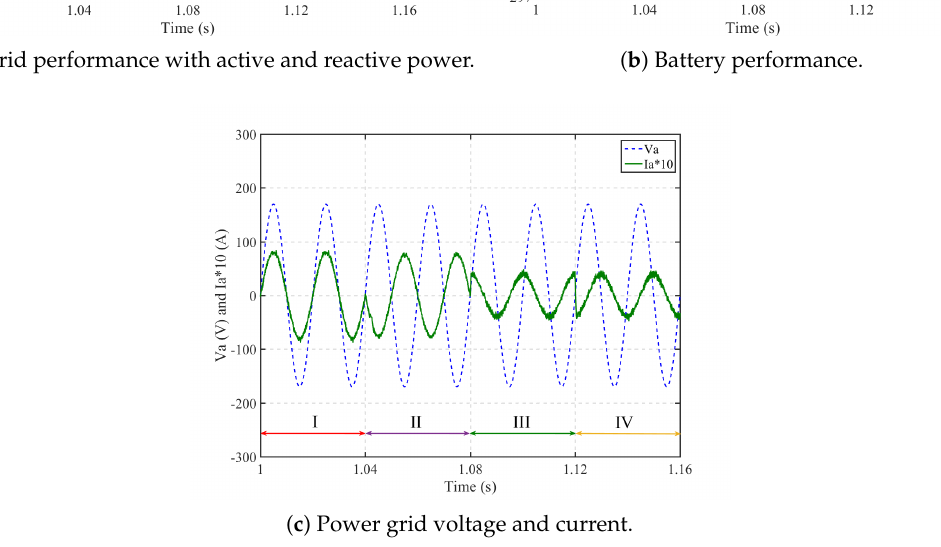
Figure 8. Simulation results in Quadrants I, II, III, and